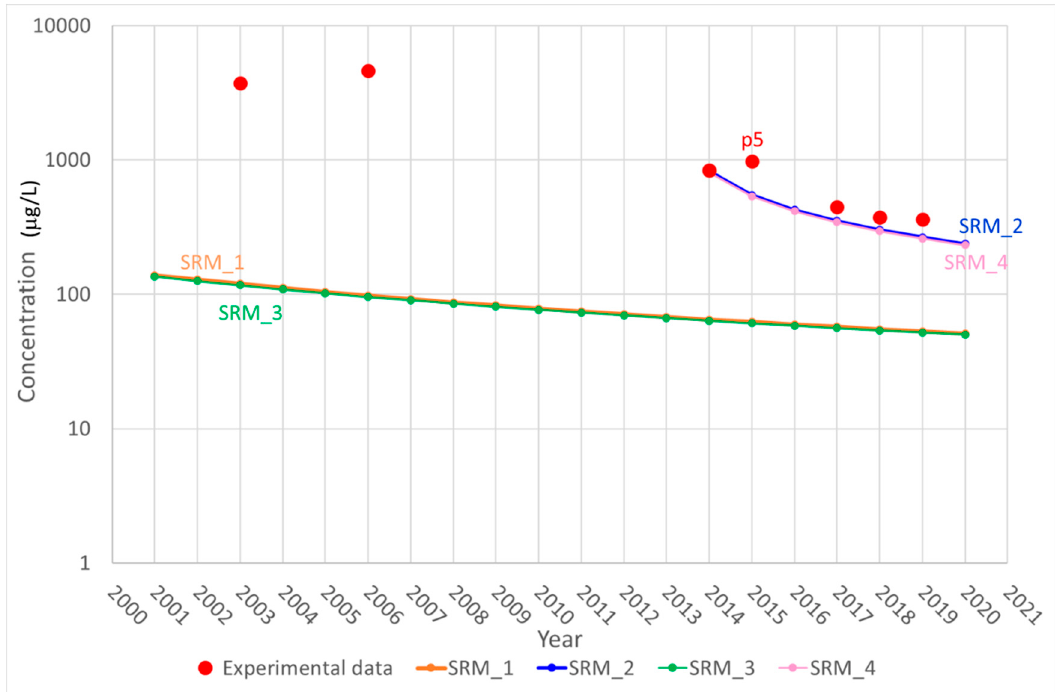
Figure 7. Measured concentrations (red points) over time and simulated concentrations without (orange and blue lines) or with (green and pink lines) a P&T system. SRM_1 and SRM_3 assume a loading period of 30 years (1960–1990), while SRM_2 and SRM_4 assume a loading period of 53 years (1960–2013).